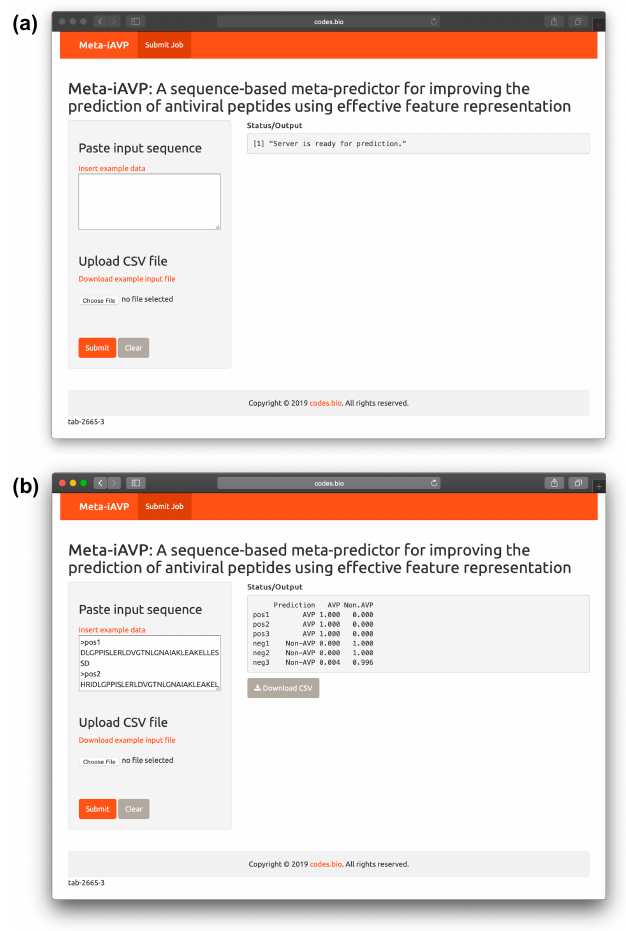
Figure 7. Screenshots of the Meta-iAVP web server before ( a ) and after ( b ) submission of sequence data for prediction. Predictions are shown alongside the probability values for each class predictions. Results are provided as a downloadable CSV file by clicking on the gray button underneath the prediction output.